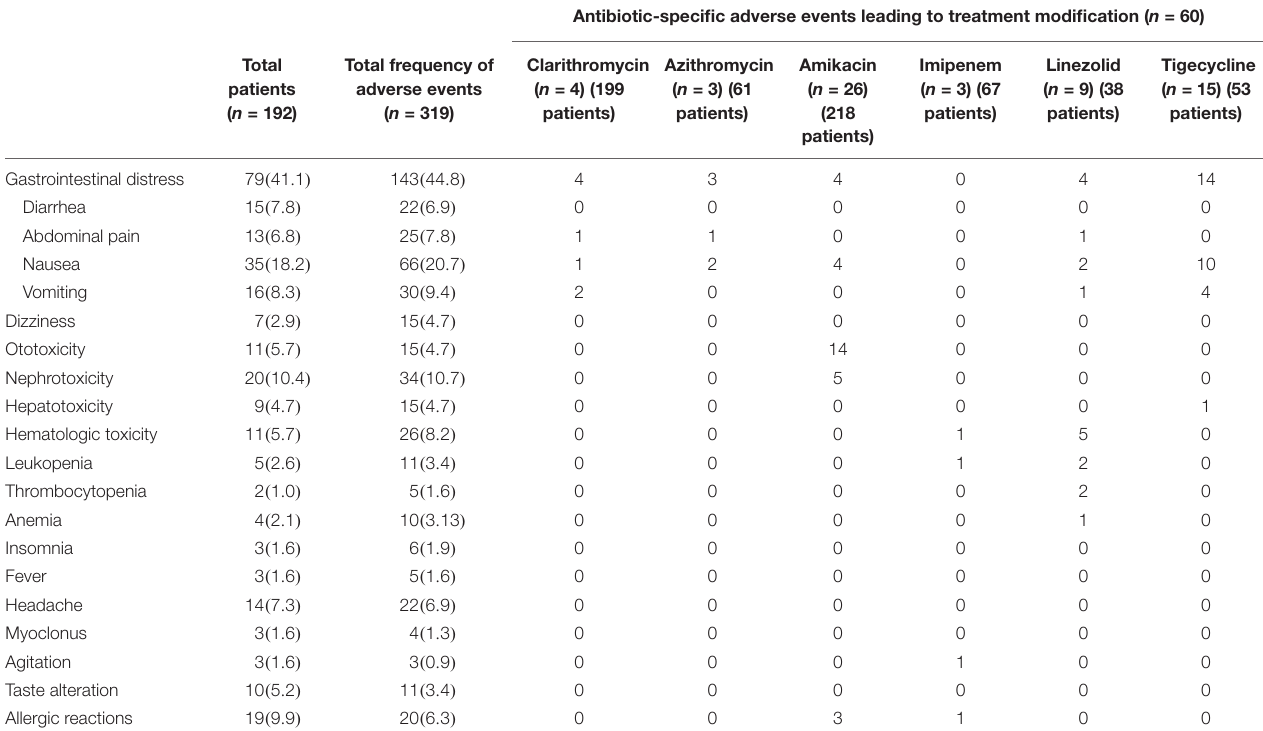
TABLE 4 | Adverse events ∗